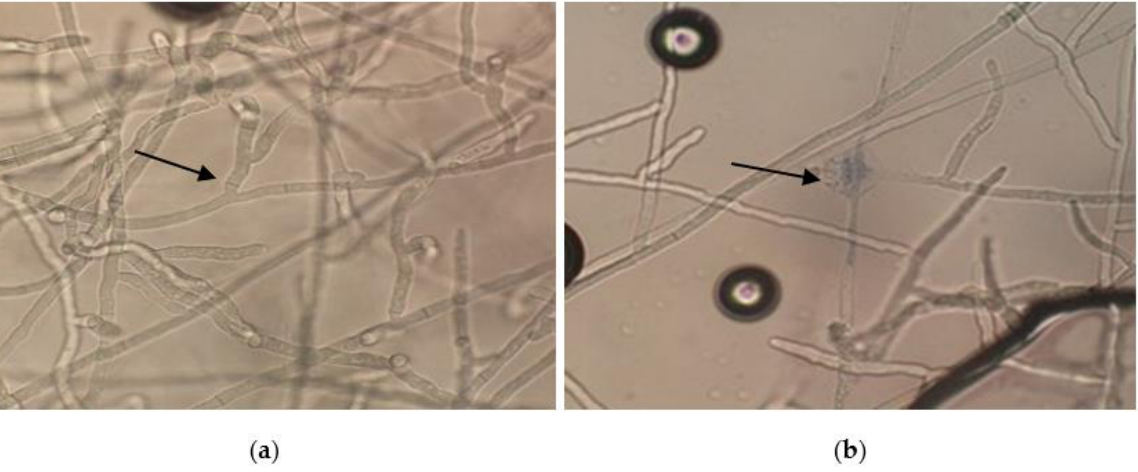
Figure 7. Microscopic aspects of R. solani cultures developed in the presence of EO 1 , C 4 = 25%; ( a ) zigzag growth of mycelial hyphae; ( b ) lysis of mycelial hyphae. ( a ) zigzag growth of mycelial hyphae; ( b ) lysis of mycelial hyphae.